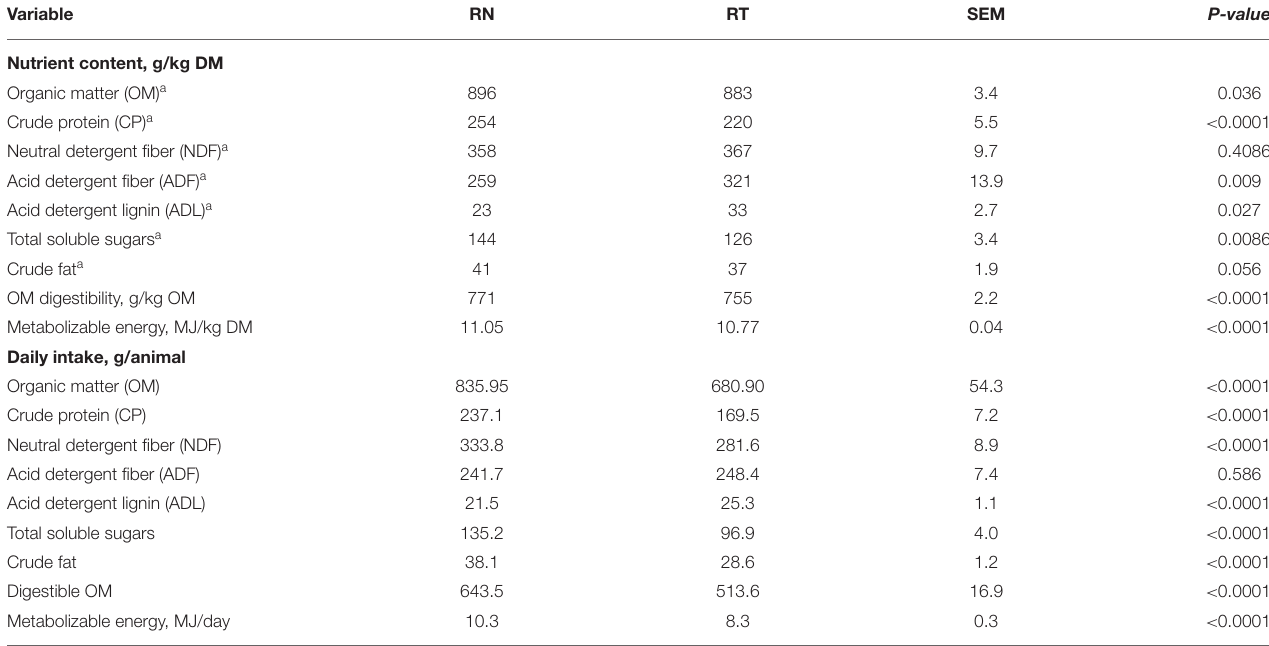
TABLE 3 | Nutrient content of the ingested diet and total nutrient intake by sheep grazing vegetative Italian ryegrass pastures under contrasting grazing management strategies (RN and RT) in rotational stocking. Variable RN